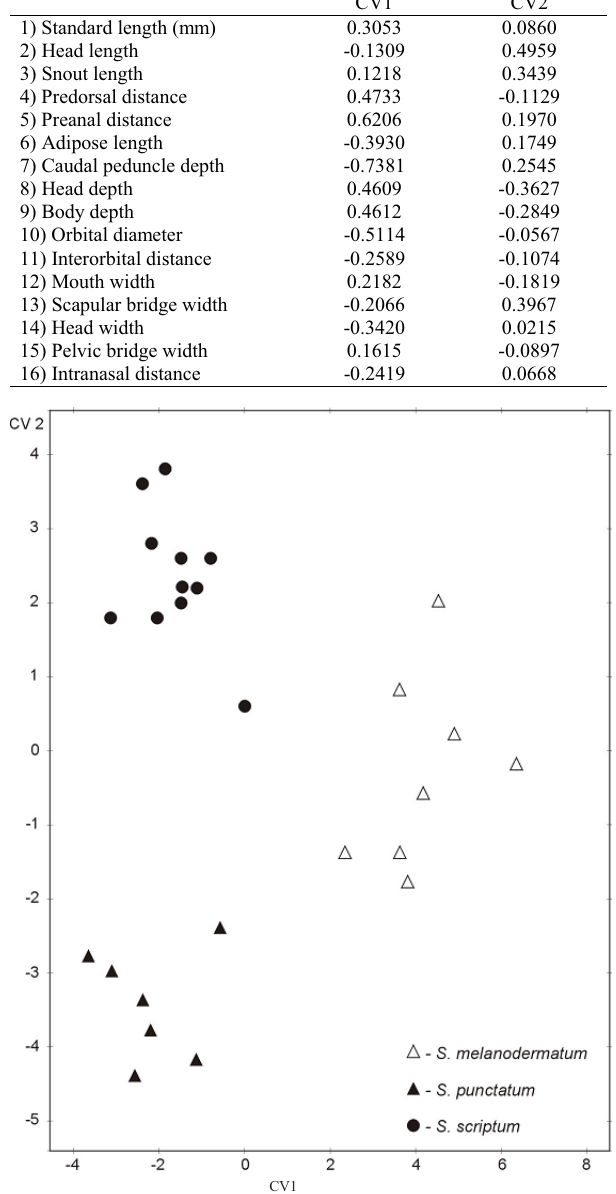
Fig. 10. Projection scores of individuals of three species of Steindachneridion from Paraná and Uruguay basins on the first two canonical variates, CV1 and